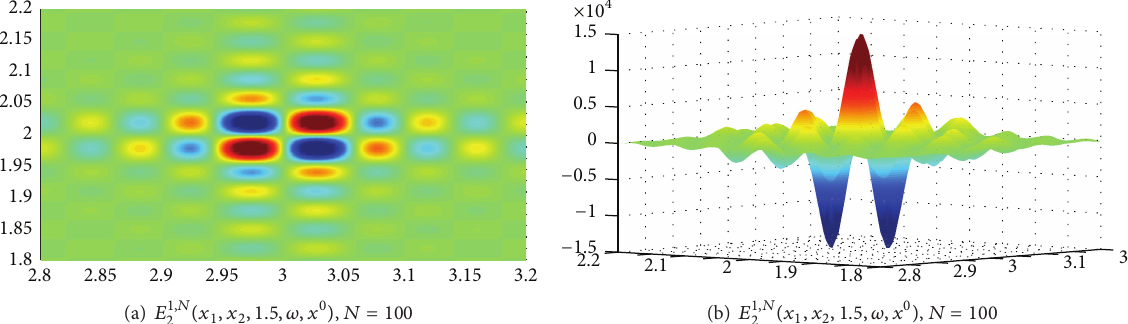
Figure 8: The second component of the first column of regularized electric Green’s function.